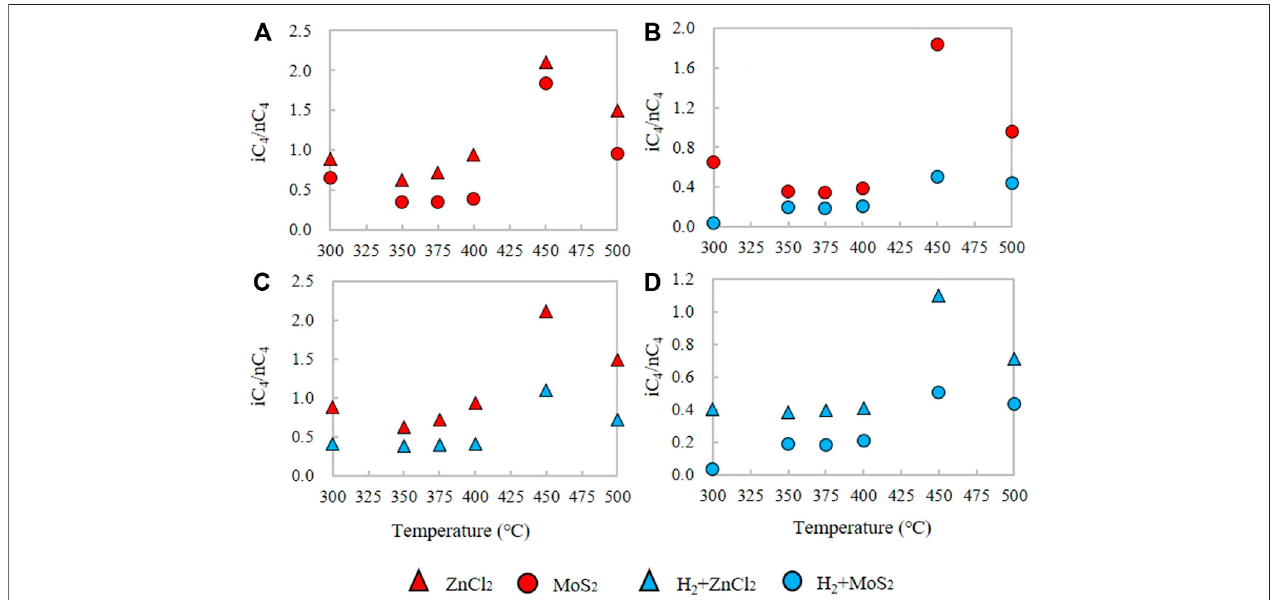
FIGURE 8 | Comparison of the iC 4 /nC 4 alkane ratio under the ZnCl 2 , MoS 2 , H 2 +ZnCl 2 , and H 2 +MoS 2 conditions for the kerogen in closed system.